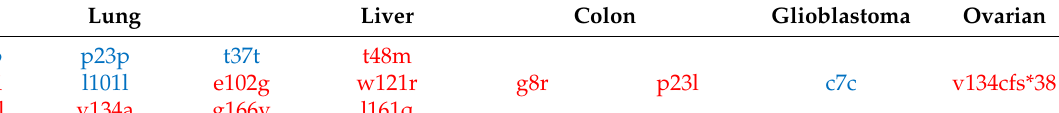
Table 1. LEP and LEPR mutations in 5 major types of